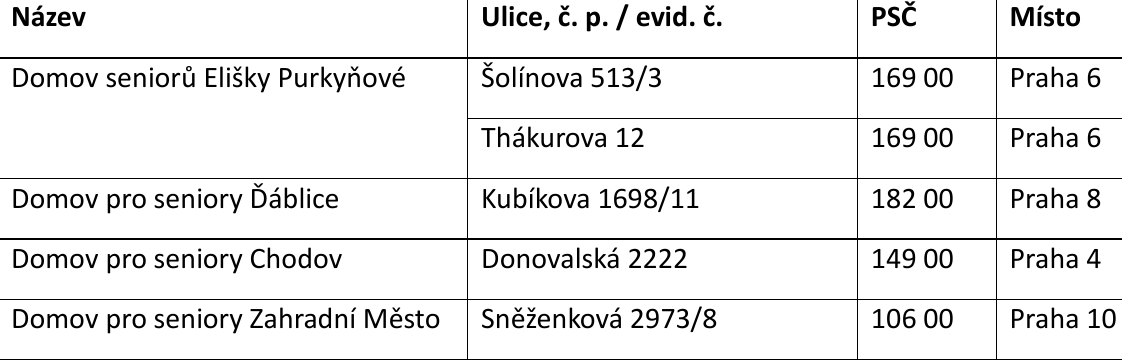
Tab 3: Budovy se službami sociální péče (Domovy pro seniory, ústavy)